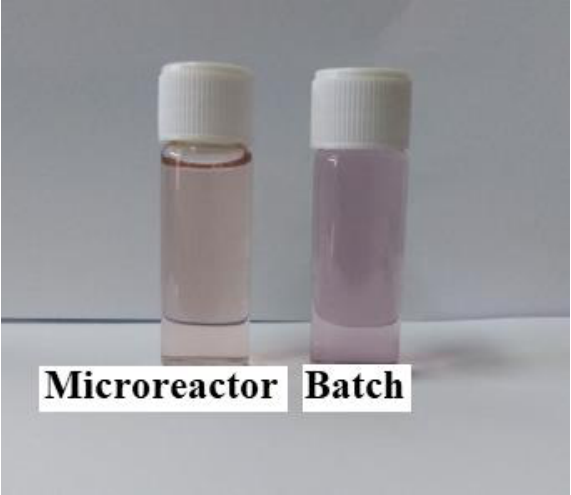
Figure 1. The UV-spectra of GNP samples prepared under optimal conditions in Microreactor mode. ( a ) in the presence of PVA stabilizer. ( b ) in the absence of the stabilizer. ( c ) In the absence of stabilizer and using the batch method.